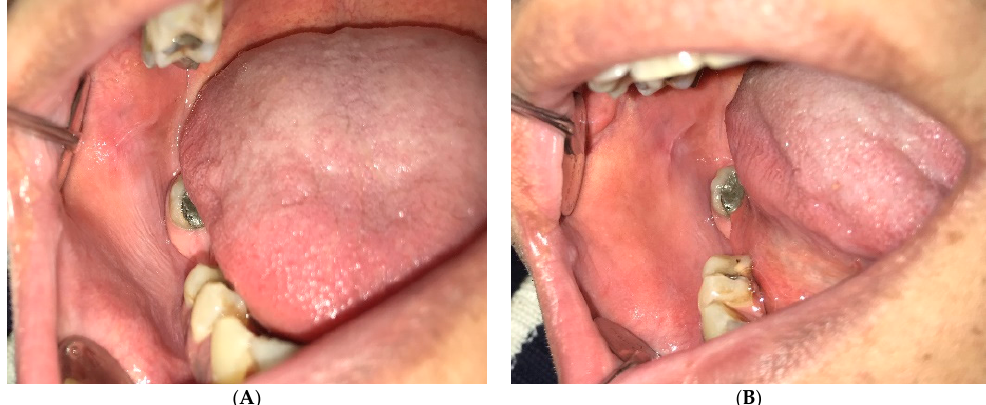
Figure 2. Leukoedema: ( A ) White appearance of buccal mucosa due to Leukoedema. ( B ) By stretching the mucosa, the white wrinkled area disappeared.